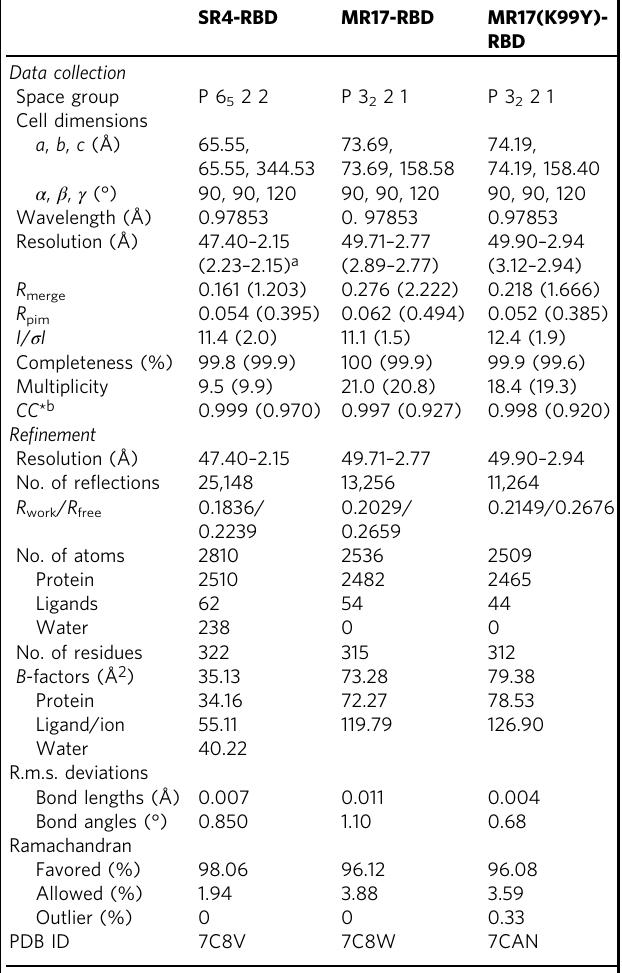
Table 1 Data collection and re fi nement